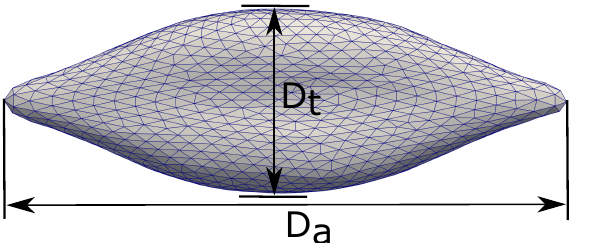
Figure 3. Definitions of the axial diameter ( D a ) and the traverse direction ( D t ). The deformation of the RBC is measured by the quantities D a and D t as shown in Figure